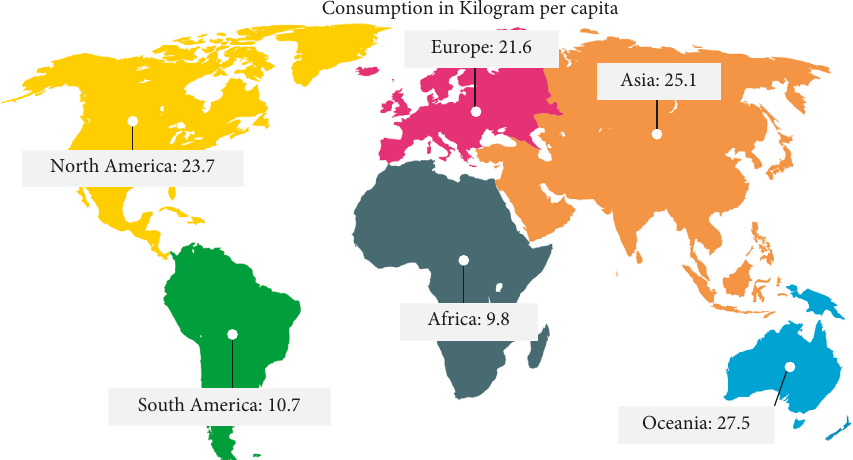
Figure 1: Global world map showing estimated fish consumption per capita in 2019 (kilograms per capita), information obtained from [19]. The shapefile of the world map required for Arc GIS Ver. 10.8 was obtained from